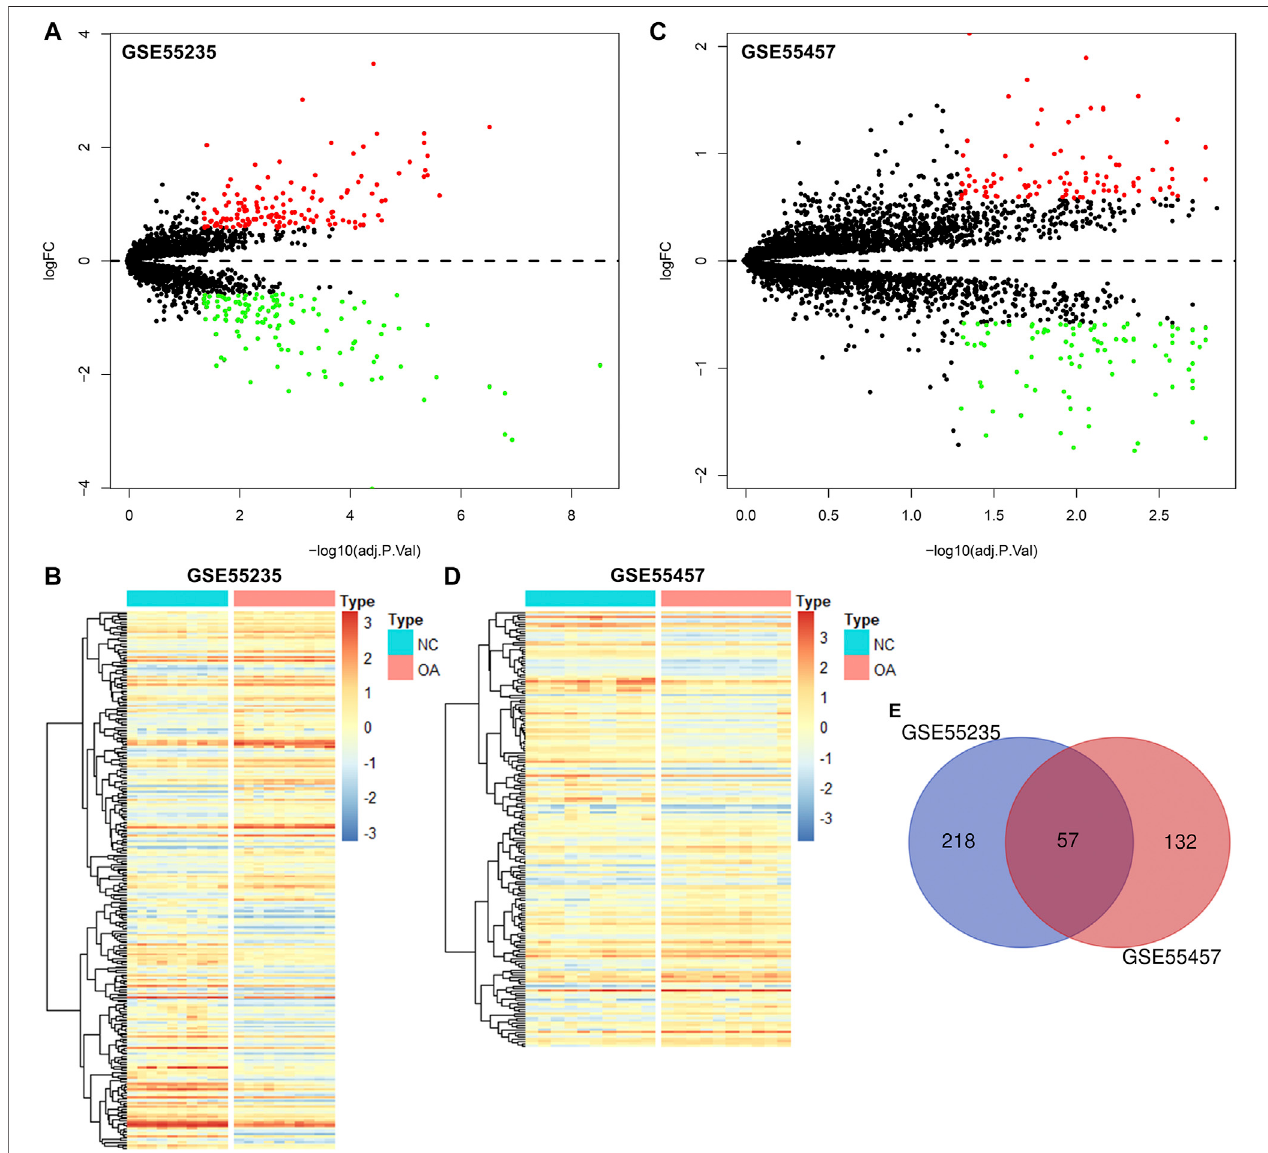
FIGURE1| Identi fi cationofDEGsforOAsynovialtissues. (A) VolcanodiagramofDEGsinOAcomparedtohealthysynovialtissuesintheGSE55235dataset.Red: up-regulation and green: down-regulation. X-axis: − log10(adjusted p-value) and y-axis: log[fold-change (FC)]. (B) Heatmap of DEGs in OA (red) than healthy (blue) synovial samples in the GSE55235 dataset. N: normal and O: osteoarthritis. (C,D) Volcano and heatmap plots of DEGs in OA than healthy synovial tissue specimens in the GSE55457 dataset. (E) Venn diagram of common DEGs in the GSE55235 and GSE55457 datasets.